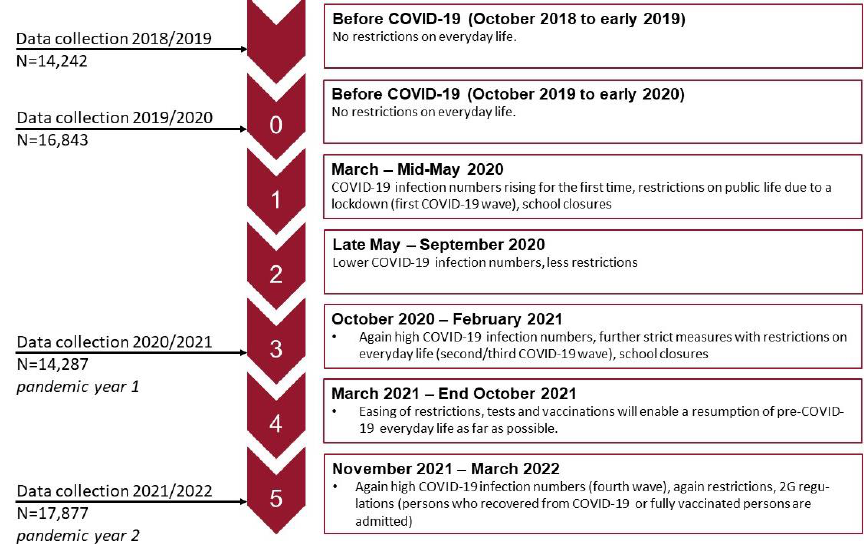
Figure 1. Pandemic stages [22] and data collection time points.